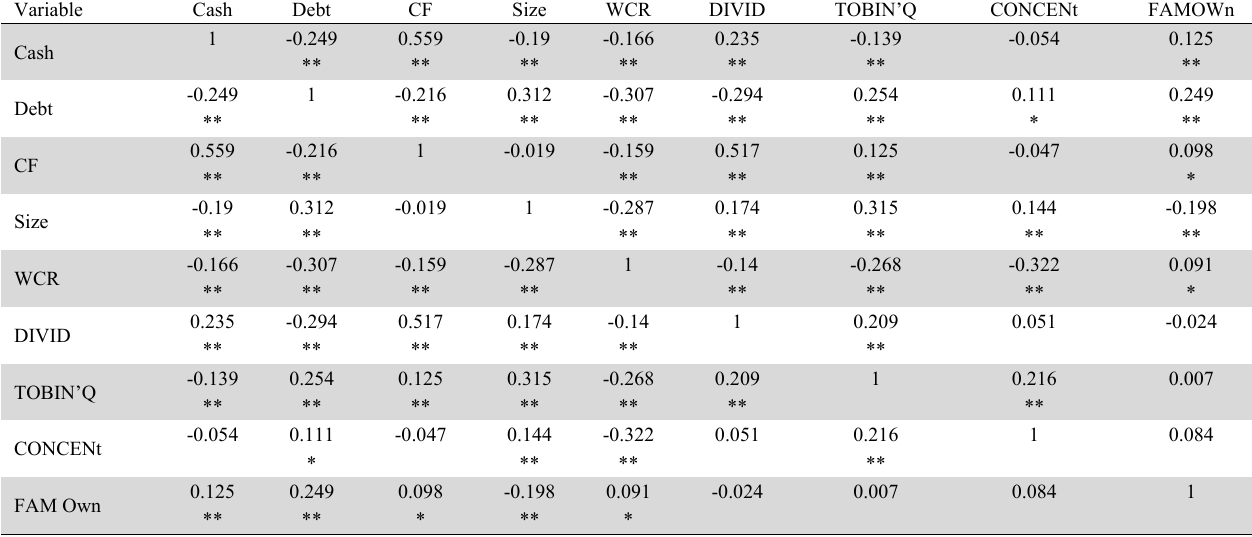
Correlation matrix